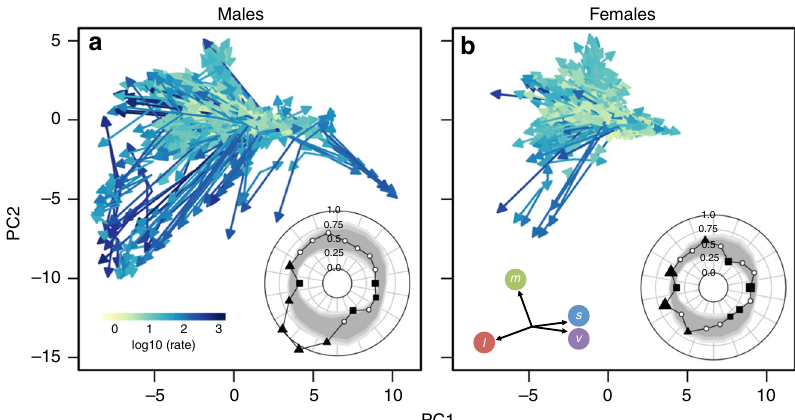
Fig. 4 The rate and direction of plumage colour divergence among Tyrannida species. Plots combine data from 10 plumage patches for males ( a ) and females ( b ) of 372 Tyrannida species. Arrows indicate the direction of evolution and are coloured according to the corresponding patch-speci fi c rate of evolution. Radar plots (inset, a and b ) show the mean evolutionary rates of divergence trajectories (black points and lines) falling within each 20 o segment of two-dimensional colour space. Grey bands indicate the 95% con fi dence intervals for the null distribution of mean rates based on a randomisation process. Filled points indicate values showing signi fi cant ( P < 0.05) deviations from the null distribution, with triangles and squares indicating faster and slower average rates than expected, respectively. Scale bar (inset, a ) and vector diagram showing the loadings of receptor stimulation variables onto PC axes (inset, b ) are relevant to both